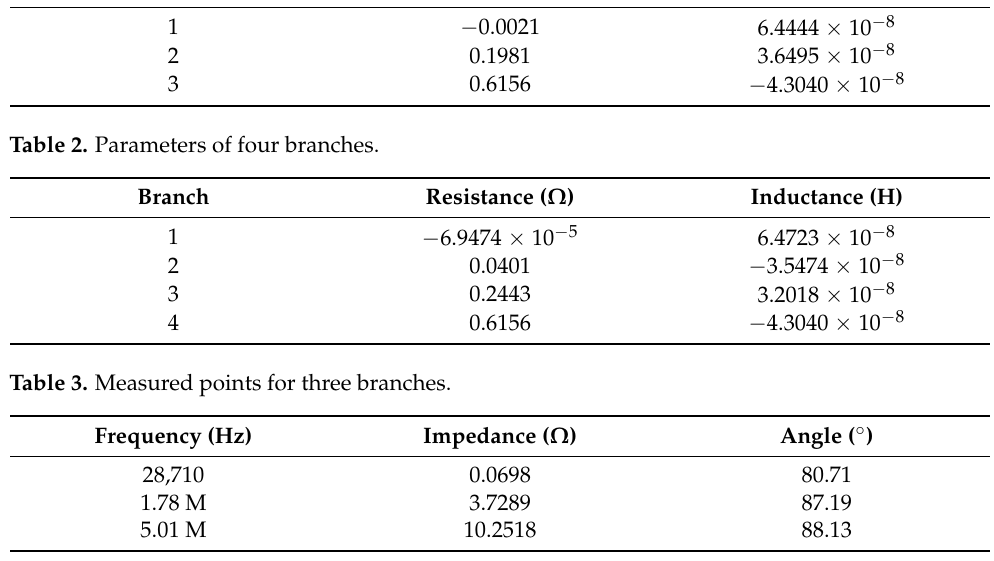
Table 4. Measured points for four